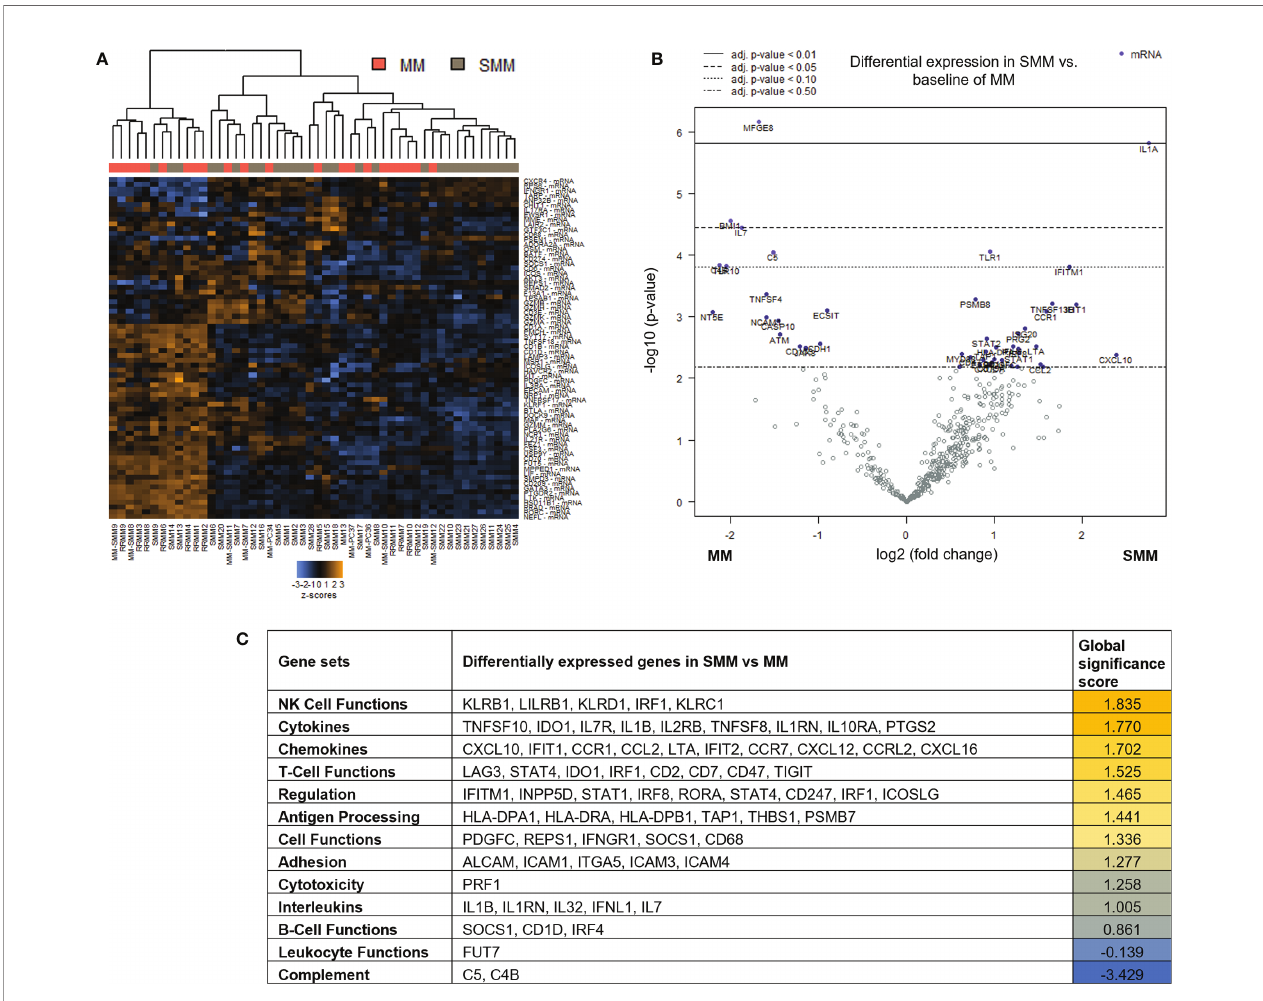
FIGURE 2 | Genes associated with NK and T cell functions were differentially expressed in patients with SMM compared to symptomatic MM (A) Heatmap showing the unsupervised hierarchical clustering of patients with MM (n=22) and with SMM (n=28) based on the NanoString PanCancer Immune panel. (B) Volcano plot showing differentially expressed genes in SMM compared to MM. (C) Ranking of gene set functions according to the Global Signi fi cance Score quanti fi ed by NanoString software nSolver